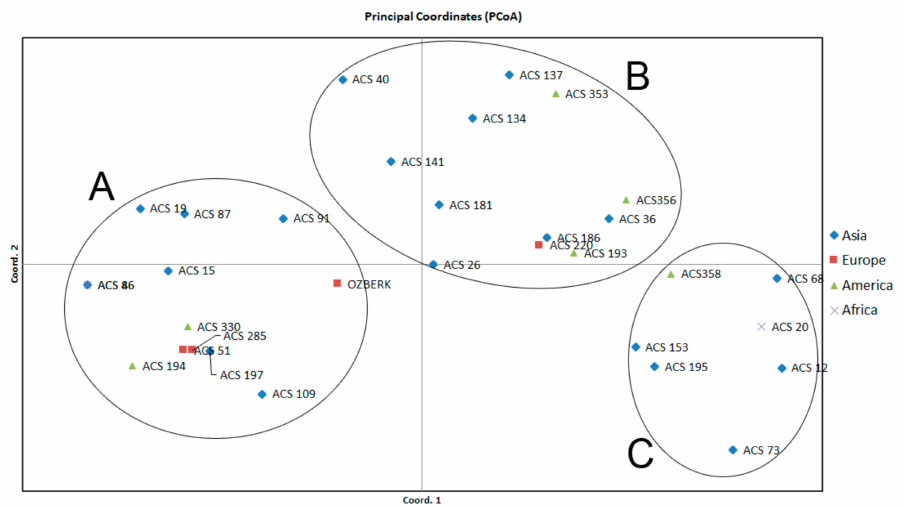
Figure 1. Principal coordinate analysis (PCoA) of the 32 sesame accessions genotyped with 16 nDel markers. ( A – C ) show the three classes with respect to distribution of